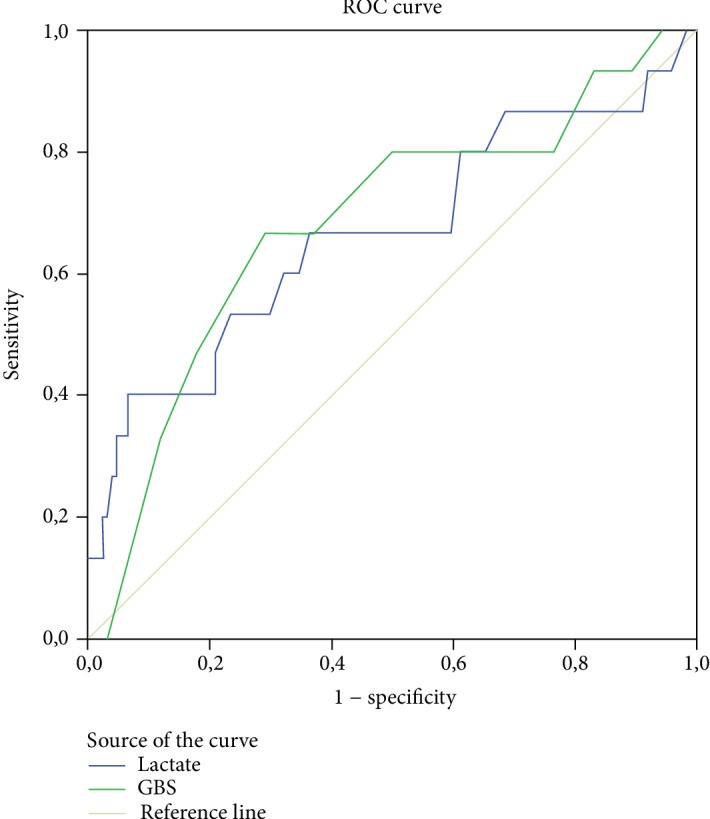
ROC curves showing comparisons of lactate and GBS in predicting hospital mortality.